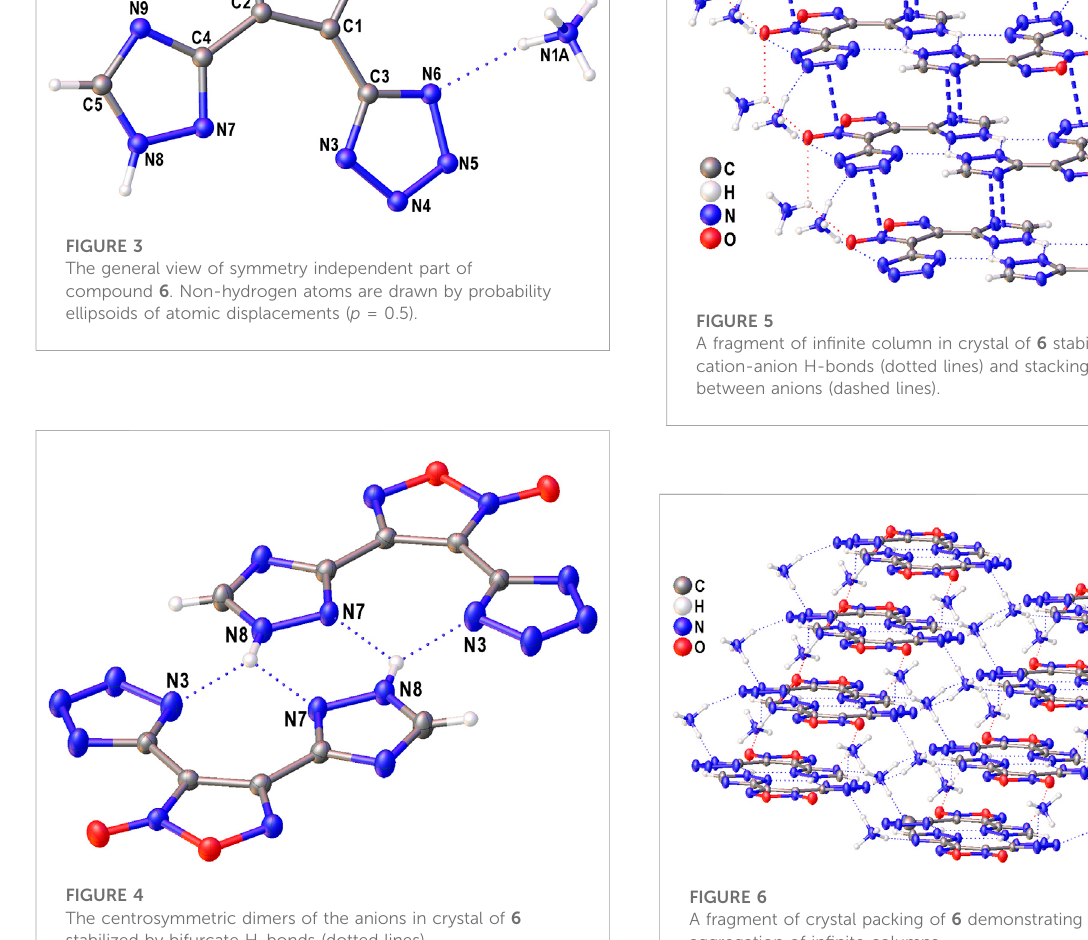
FIGURE 4 The centrosymmetric dimers of the anions in crystal of 6 stabilized by bifurcate H-bonds (dotted lines).